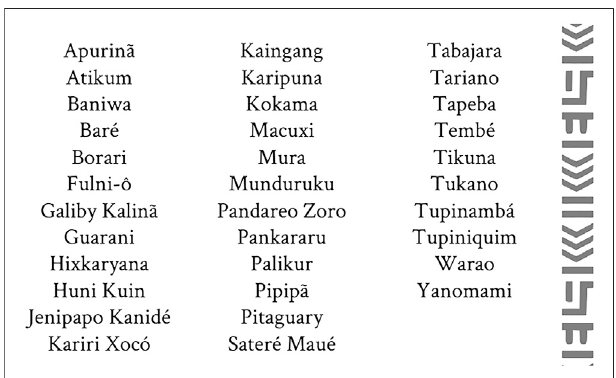
FIGURE 1 | Instituto Socioambiental,